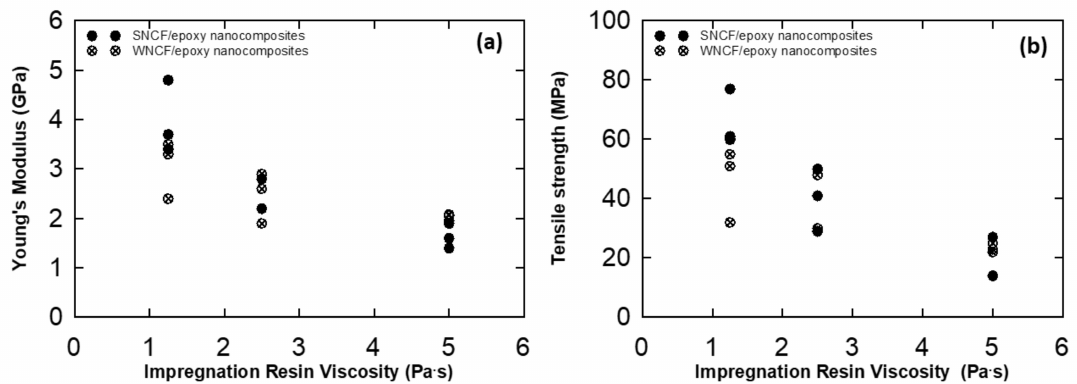
Figure 8. Young’s modulus ( a ) and tensile strength; ( b ) of the CNF / epoxy nanocomposite films as a function of the impregnation resin